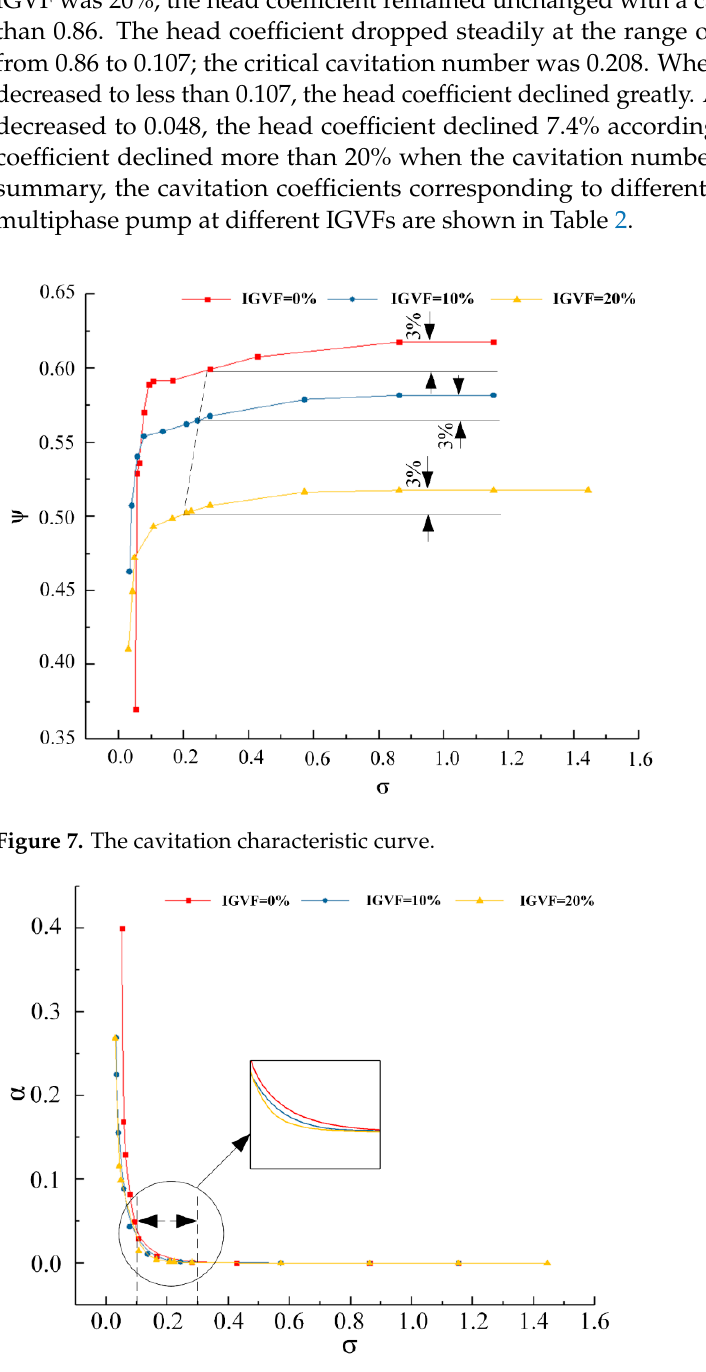
Figure 8. The variation of the vapor volume fraction within the impeller with the cavitation number.